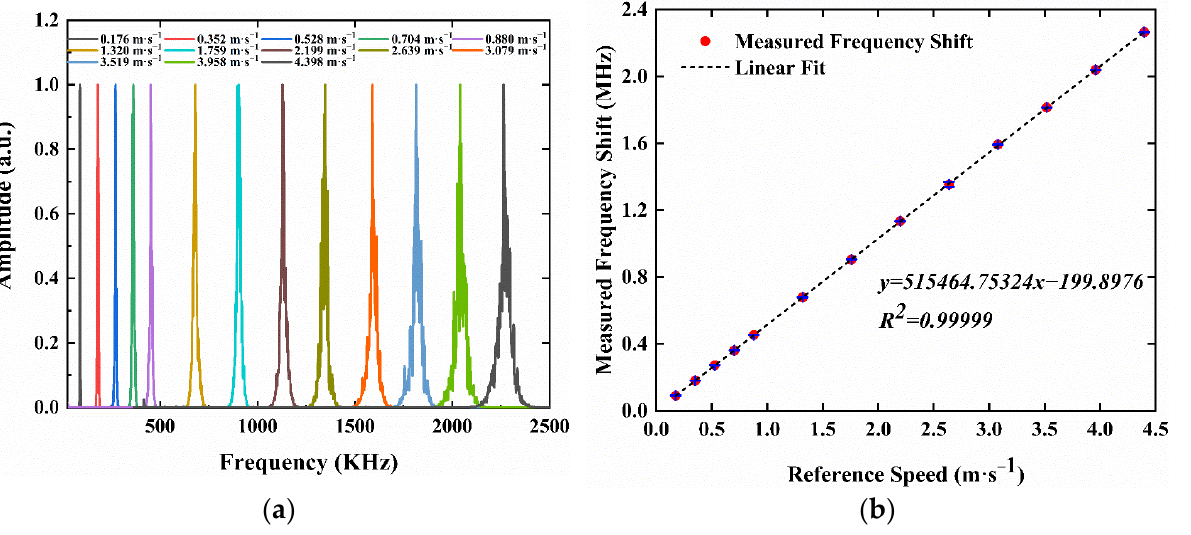
Figure 6. Measurement and fitting results of the speed of the rotating disk. ( a ) Frequency shift wave packet of the measured scattering light with a velocity range from 0.176 m·s −1 to 4.398 m·s −1 ; ( b ) The relationship between measured frequency shifts and reference speeds.